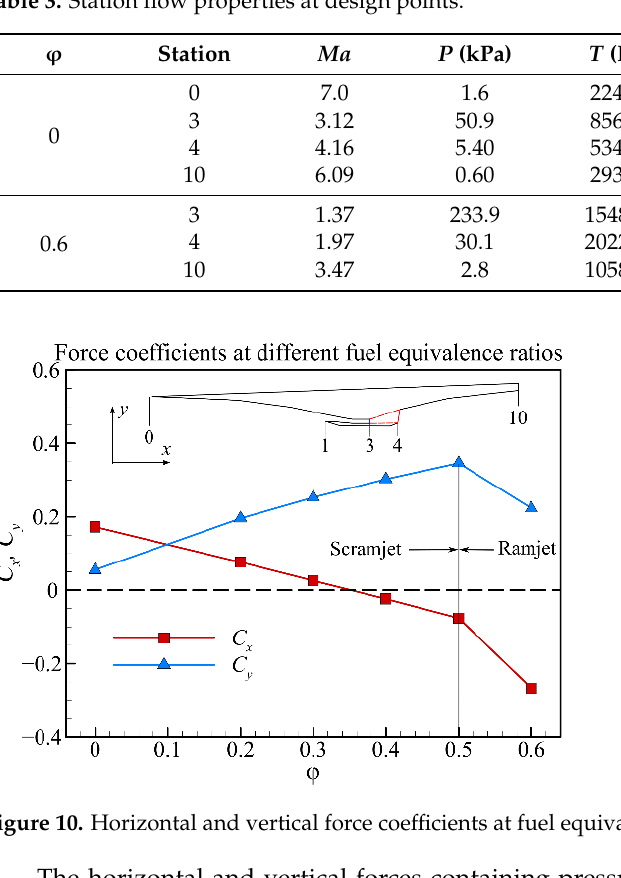
Table 3. Station flow properties at design points.